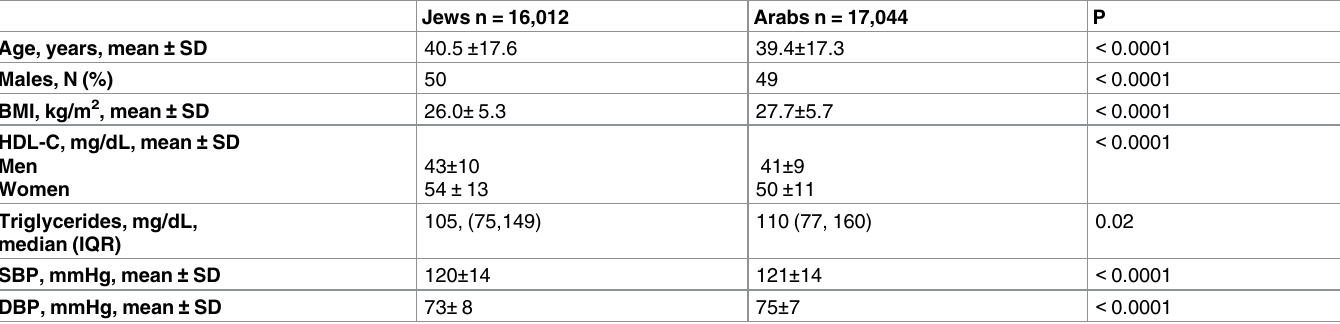
Table 1. Baseline characteristics of the study cohort.